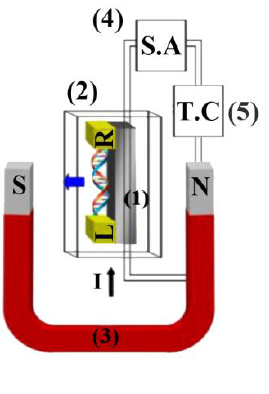
Figure 1. Experimental design with labels: (1) chip holder and connection in a Dewar, (2) cryostat system, (3) magnetic field generator and detector, (4) semiconductor analyzer for I-V measurement and (5) thermal controller.